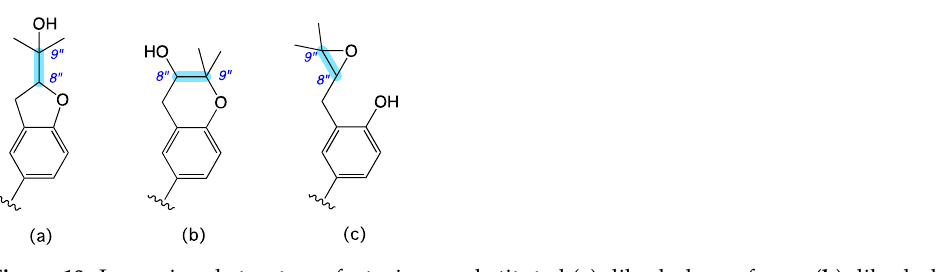
10 of 18 Figure 9. Structures for known aflaquinolones and analogues 32 – 38 . Highlighted: carbo/heterocyclic scaffold (green). HRESI(+)MS measurement on 14 returned a molecular formula (C 27 H 28 O 6 , Δ mmu-2.4) suggestive of an oxidized (+O) analogue of the co-metabolite aspulvinone B ( 16 ). Compar- ison of the 1D NMR (methanol- d 4 ) data for 14 (Tables 4 and S10, Figures S43–S46) with the 1D NMR (acetone- d 6 ) data for 16 (Figure S52, Note— 16 proved insoluble in methanol) revealed a high level of similarity, with key differences attributed to replacement of the isoprene D 8",9" moiety in 16 (d H 5.36, m, H-8 ″ ; δ C 123.3, C-8 ″ ; δ C 133.1, C-9 ″ ) with a dioxy- genated moiety in 14 ( δ H 3.82, dd, H-8 ″ ; δ C 69.4, C-8 ″ ; δ C 78.3, C-9 ″ ). The latter resonances could in principle be attributed to three possible substructures (Figure 10) consisting of a dihydrobenzofuran, a dihydrobenzopyran, or an epoxide. The dihydrobenzofuran moiety (Figure 10a) is prominent among known aspulvinones (Figure S62) and features a con- sistent range of 13 C NMR (methanol- d 4 ) chemical shifts for C-8 ″ ( δ C 89.9–91.4) and C-9 ″ ( δ C 71.1–73.1) [16,31]. While the dihydrobenzopyran moiety (Figure 10b) is less common among known aspulvinones (Figure S62), there are nevertheless reports of the 13 C NMR (methanol- d 4 ) chemical shifts for C-8 ″ ( δ C 68.7–71.0) and C-9 ″ ( δ C 77.2–77.5) [16]. Finally, although there are no known accounts of aspulvinones featuring an epoxy moiety (Figure